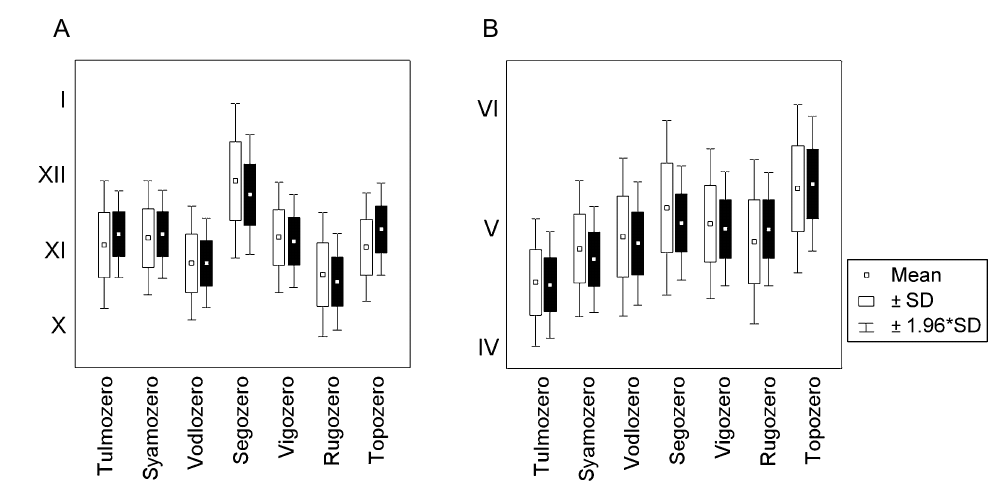
Fig. 8. Average, earliest and latest observed (light) and model (black) freeze dates ( A ) and the break-up dates ( B ) of lakes in Karelia. The lakes are ordered along the horizontal axis according to their location from south to